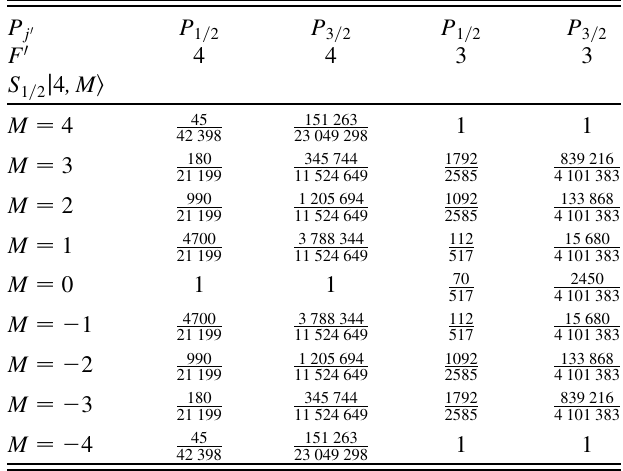
that an atom, M , 1 = 2